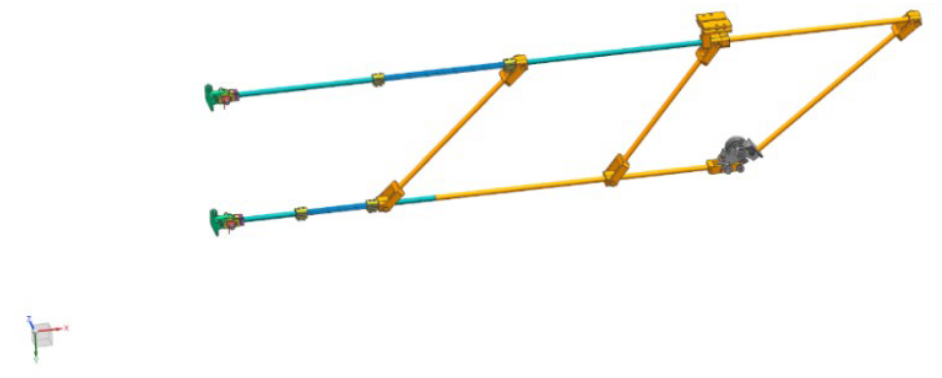
Figure 3. Truss support structure of the thin-film diffraction imaging